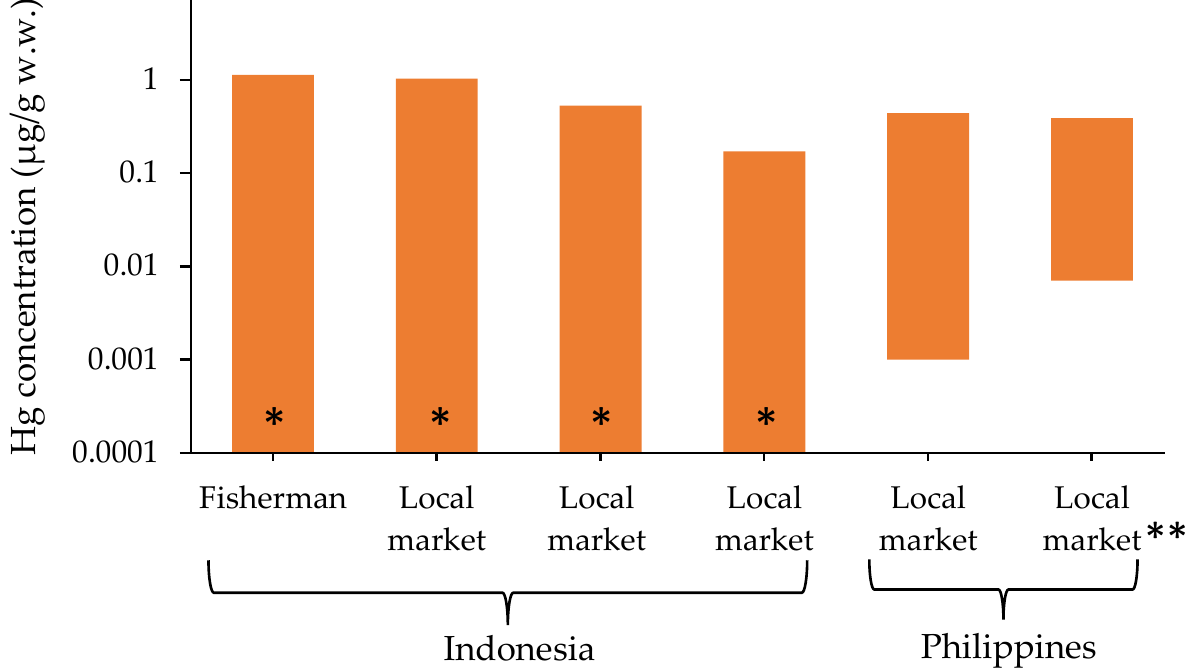
Figure 9. Hg concentrations in fish from Indonesia [59] and the Philippines [37]. Each datum represents Hg concentration of range value, which was from a single study. *; minimum value of “0”, **; MeHg concentration.